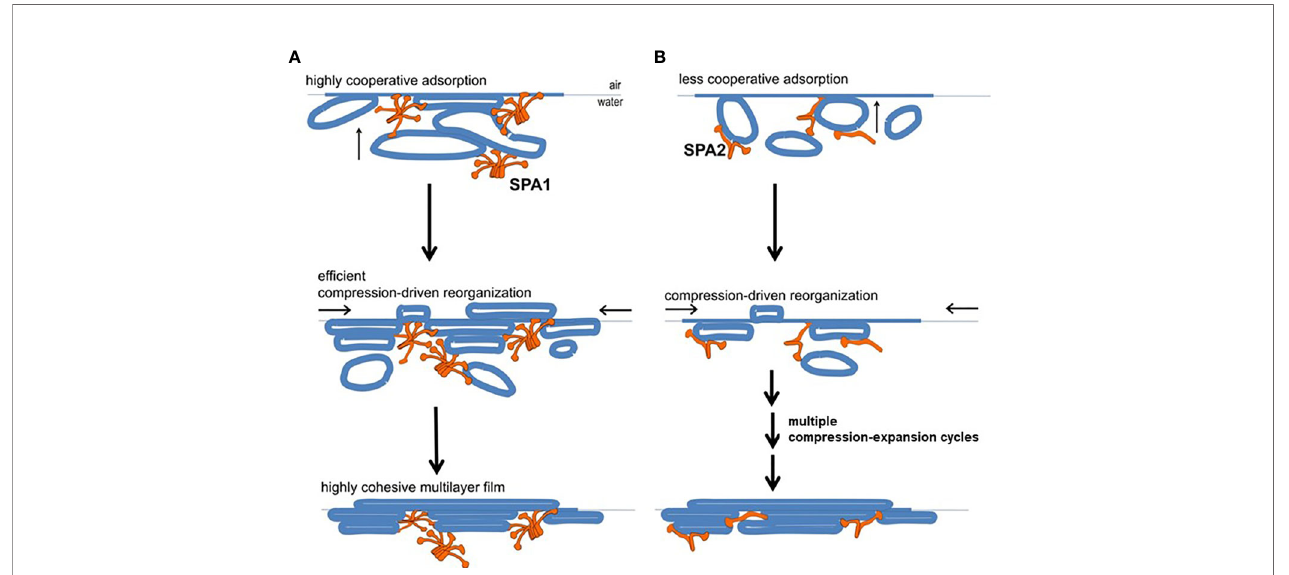
FIGURE 6 | Model of behavior of surfactant lipid complexes in the presence of SP-A1 or SP-A2 proteins. (A) depicts the multivalent binding capacities of SP-A1. The higher SP-A1 multivalent binding capacity is advantageous as it brings together several membrane aggregates and forms complex fi lms. This is due to its higher oligomerization state that is mediated in part by the presence of Cys85. These complex fi lms, upon compression-driven reorganization, could rapidly generate highly cohesive multilayer fi lms that can reach very low surface tension. (B) depicts how SP-A2, which is less oligomerized and exhibits lower binding capacity, forms surface fi lms with lower density of membranes (i.e., less complex fi lms). These simpler fi lms can still be reorganized in a cohesive multilayer fi lm to impart low surface tension but they require repetitive compression-expansion cycling. Therefore, part of the energy needed for the initial compression-expansion cycles will be spent to promote folds and membrane-membrane contacts needed prior to generating the cohesive multilayer fi lm, making this process less ef fi cient